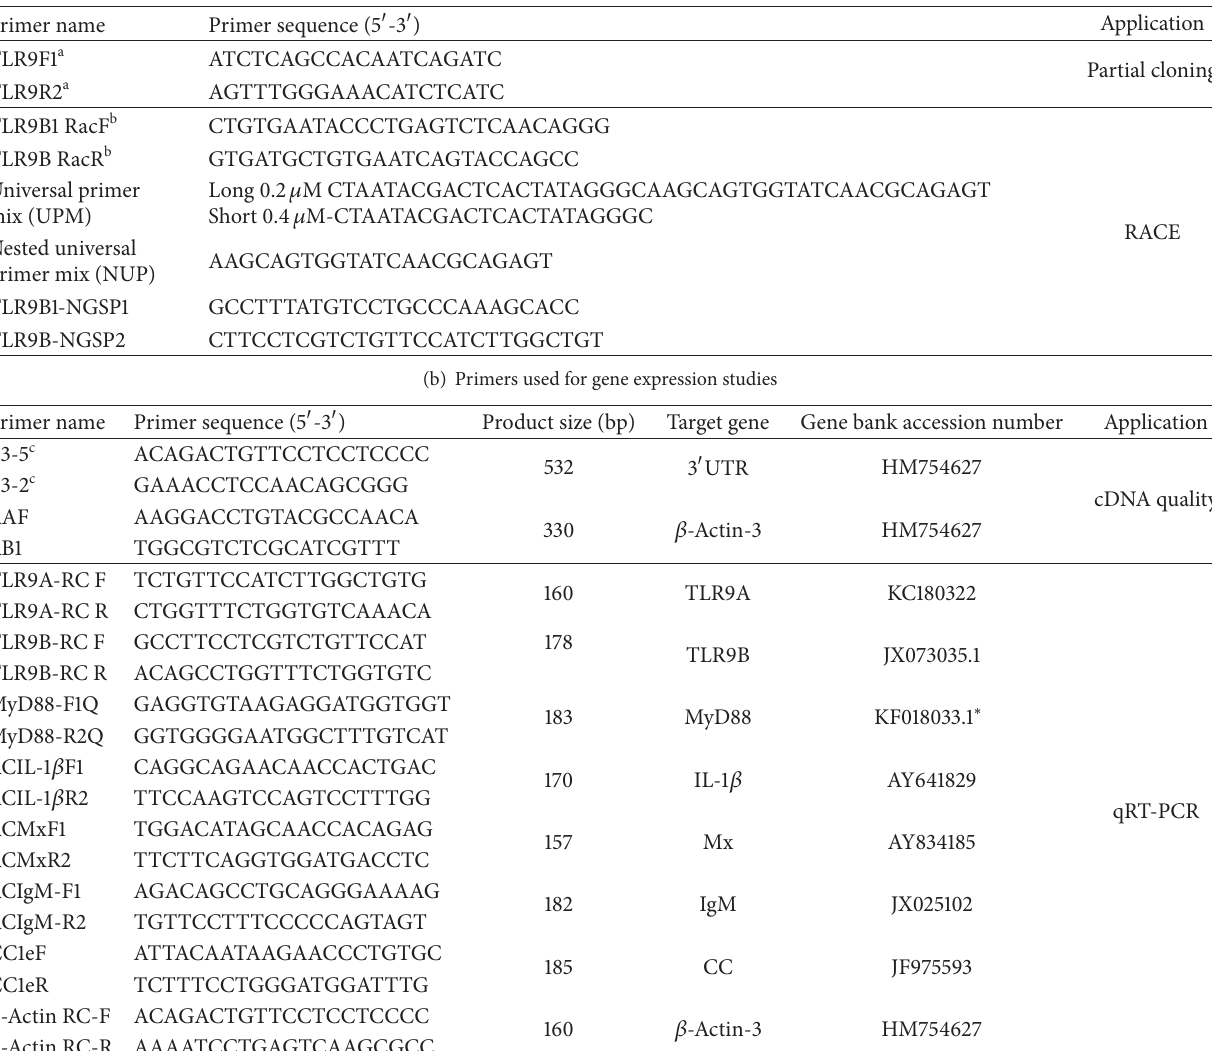
Table 1: Primer name, sequence, product size, and target gene details used in this study. (a) Primers used for cloning of TLR9 isoform